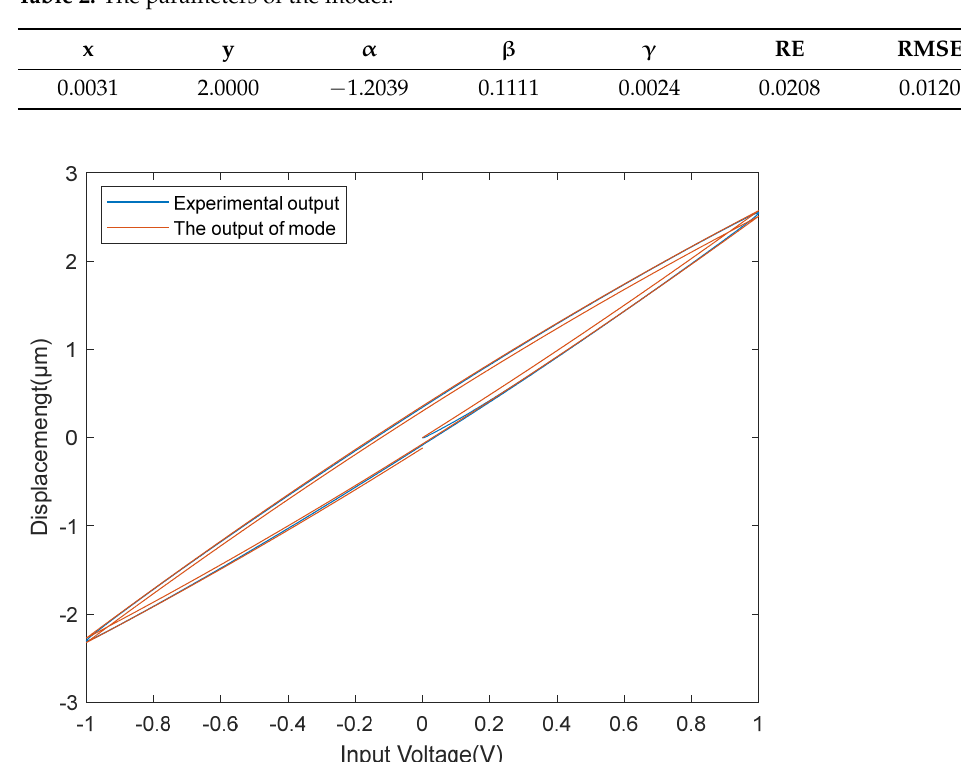
Figure 7. The input and output curves of the experimental equipment and model when the input signal frequency is 1 Hz.